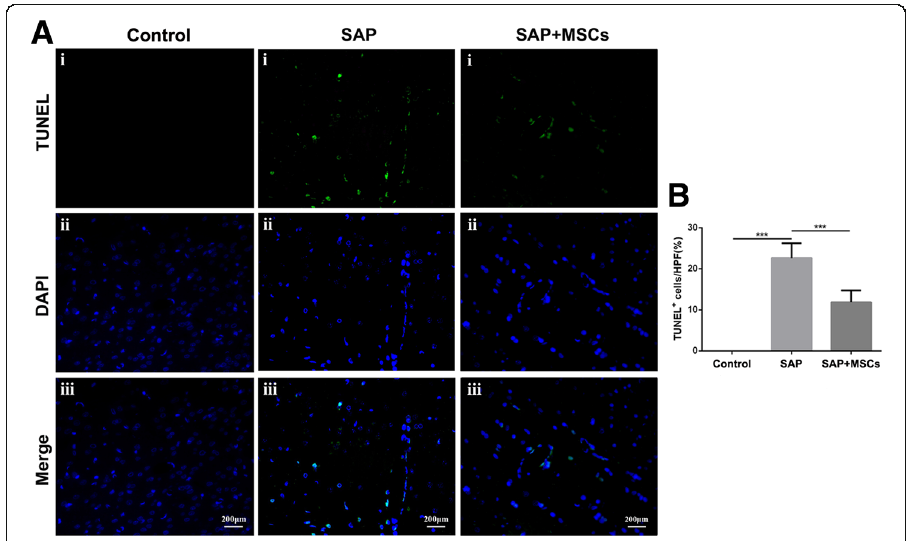
Fig. 5 MSCs reduced BMEC apoptosis in the brains of SAP rats . a TUNEL staining of the brain, scale bar = 200 μ m. No apoptosis was observed in the control group, but numerous apoptotic cells, mainly BMECs, were observed in the SAP group. Fewer apoptotic cells were observed in the SAP+MSCs group than in the SAP group. b Statistical analysis of TUNEL-positive cells. *** p <